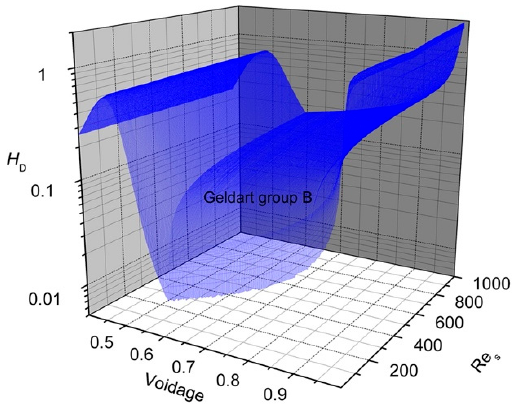
Figure 7. Dependence of the heterogeneity index 𝐻 (cid:3005) of the EMMS model on the Reyonlds’ num- ber and voidage for a particle of Geldart’s group B. Reprinted from [76], with permission from Elsevier.